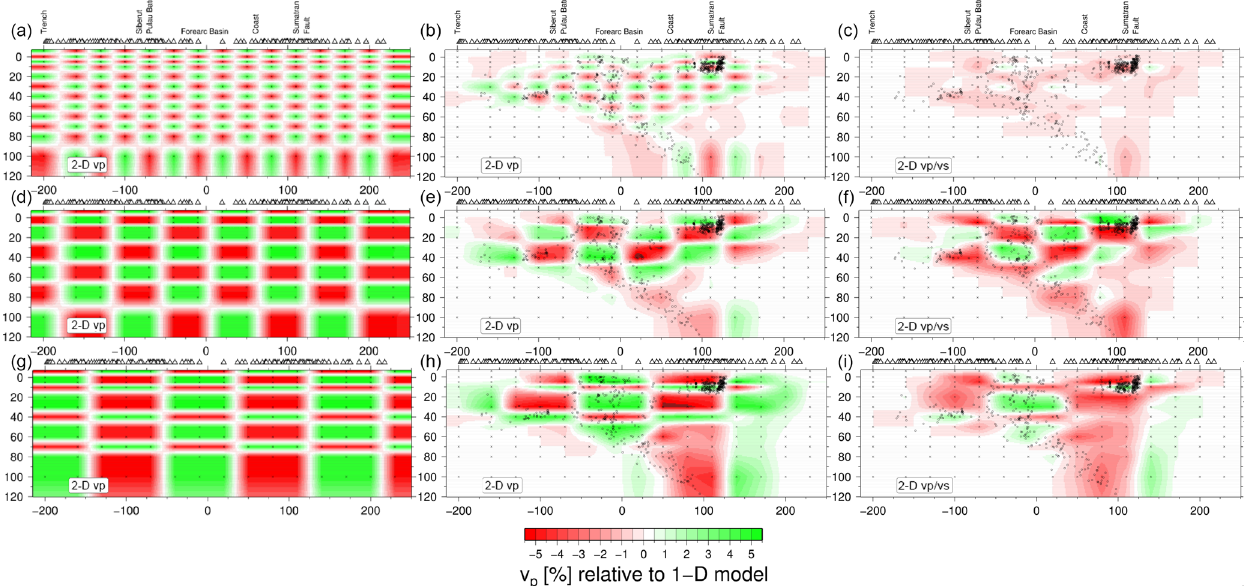
Figure 5. 2-D synthetic checkerboard models with 5% velocity perturbation input anomalies (a, d, g) , the inversion restoration for v p (b, e, h) and v p /v s (c, f, i) models. Crosses represent nodes used in the inversion and the reconstructions are plotted with the resulting hypocenter locations (black points). We calculated different checkerboard inversions using 1 × 1 and 2 × 2 (shown in the rows from top to bottom) grid node model perturbations. Noise was added to the synthetic data depending on the quality of the